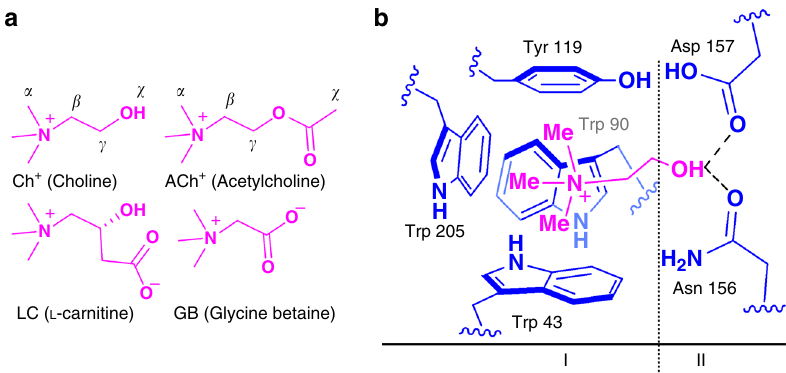
Fig. 2 The recognition mode of choline-binding protein ChoX. a Structures of choline and its derivatives, showing that they possess the same trimethylammonium head and a slightly different tail. b ChoX exhibits a synergistic dual-site-binding mode, where an “ aromatic box ” (site-I) provides the binding af fi nity for the trimethylammonium head, and two carboxyl groups (site-II) generate the critical differences in af fi nity for discriminating structural analogues 2